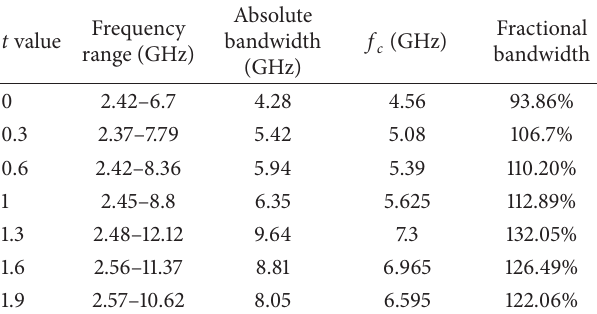
Figure 5: Return loss coefficients of different blending coefficient 𝑡 values. Table 1: Bandwidth comparison for various t values.